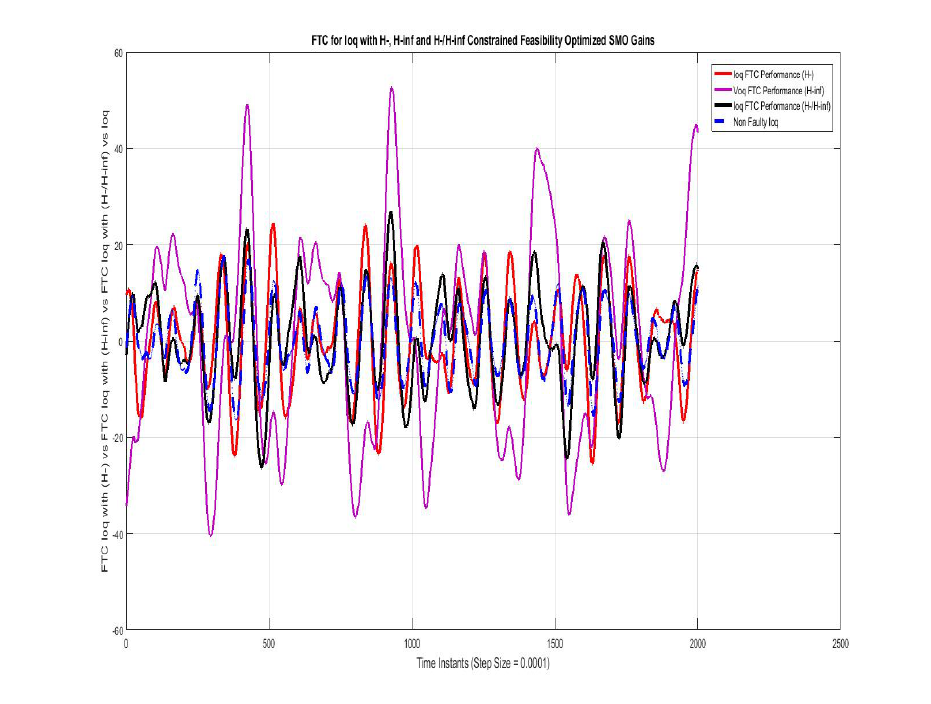
Figure 13. FTC for Vod compared with feasibility optimized H − and H − / H ∞ SMO gains. Figure 14 shows the FTC performance for the q-component of sensor output voltage ( V ) compared using SMO with gains optimized with fault sensitivity parameter ( H − ) , q robustness to disturbance parameter ( H ∞ ) , and a mixed ( H − / H ∞ ) with non-faulty actual V q . The results with all three are comparable and not very differentiating w.r.t each other.